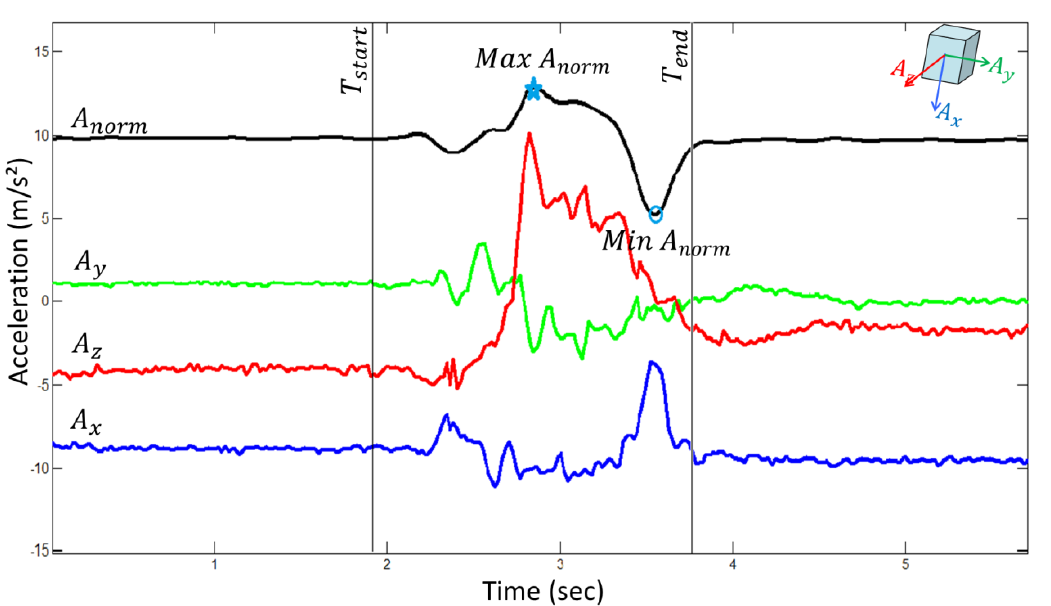
Figure 1. 3D acceleration (color) and norm (black) of the acceleration of a chair rise transfer.